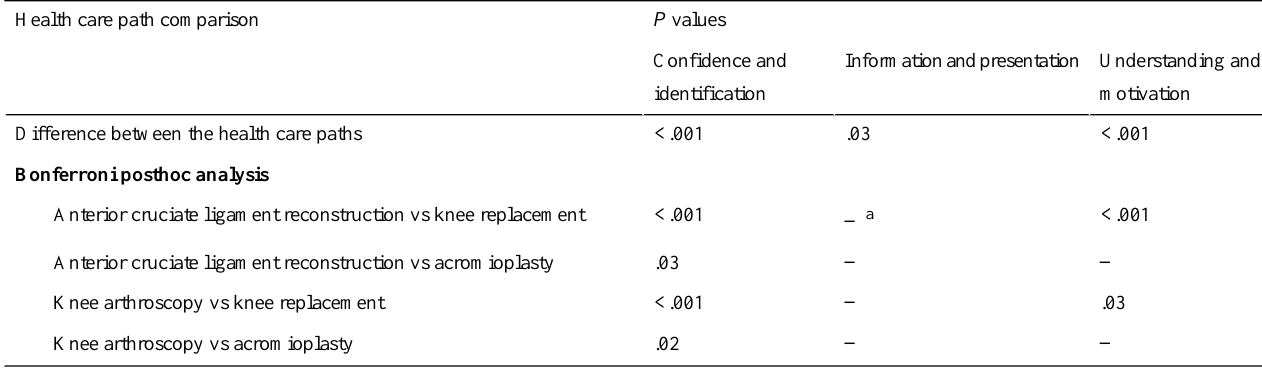
Table 4. Comparison results of the health care paths.